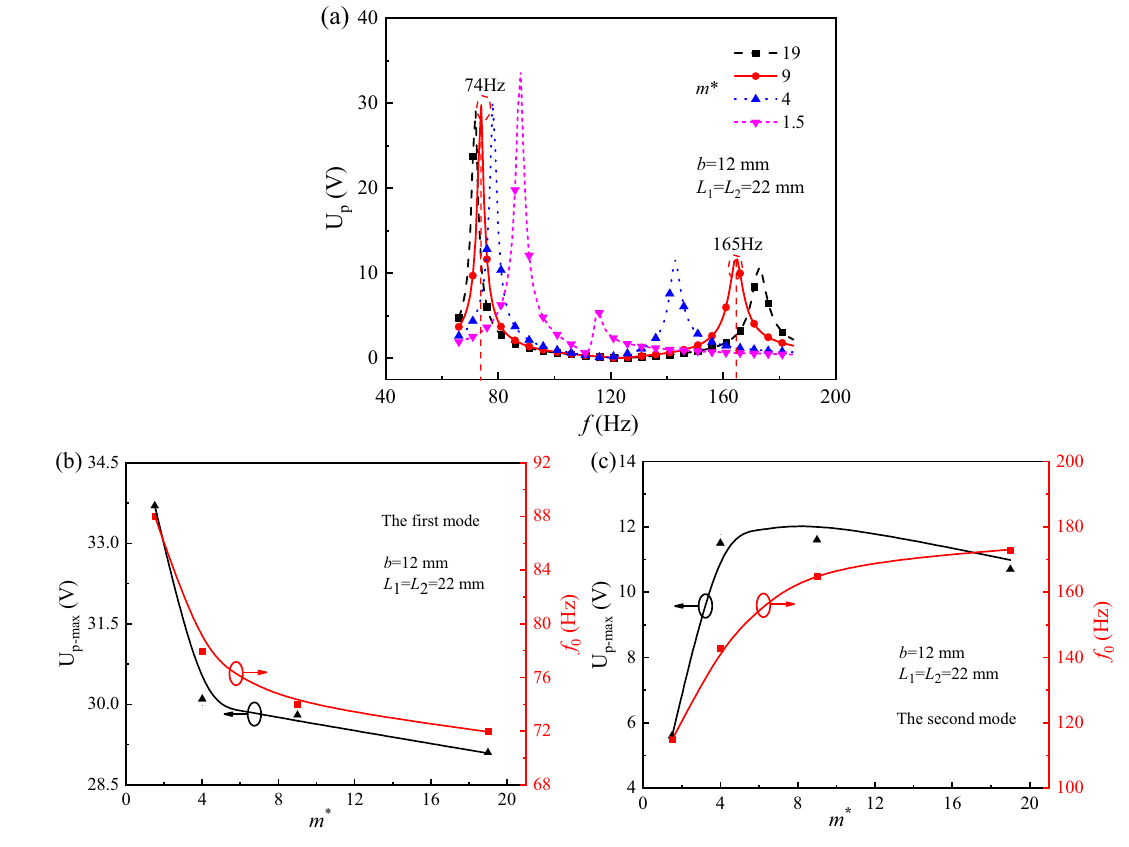
Figure 4. The U p - f curves ( a ), U p-max and f 0 vs m * curves at the first ( b ) and second ( c ) modes of